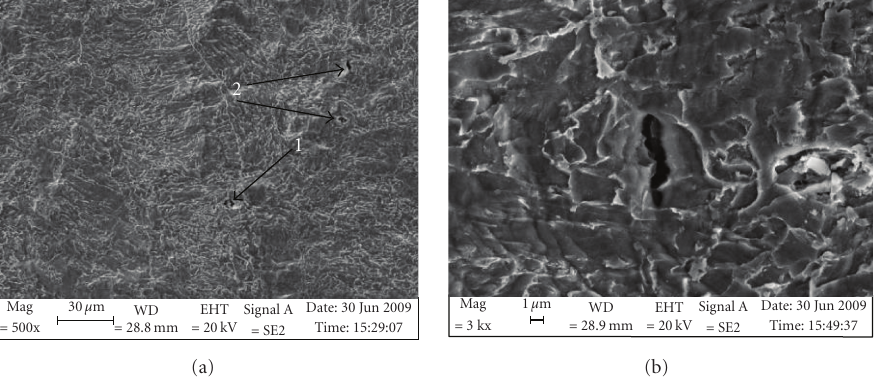
Figure 5: Microcrack formation during stretches process (a) and enlargement picture